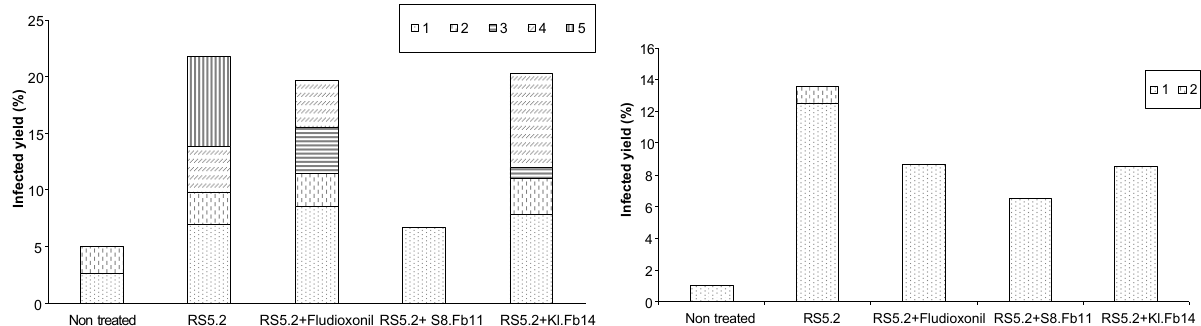
Figure 2. Mean proportions of potato tubers of the cultivars ‘Spunta’ (A) or ‘Nicola’ (B) in severiy scores 1 (low disease) to 5 (severe disease) (Brewer and Larkin, 2005), from plants grown in a field trial, which were inoculated with Rhizoctonia solani isolate RS5.2 and treated with a fungicide (fludioxonil) or two different bacterial strains (S8.Fb11 or